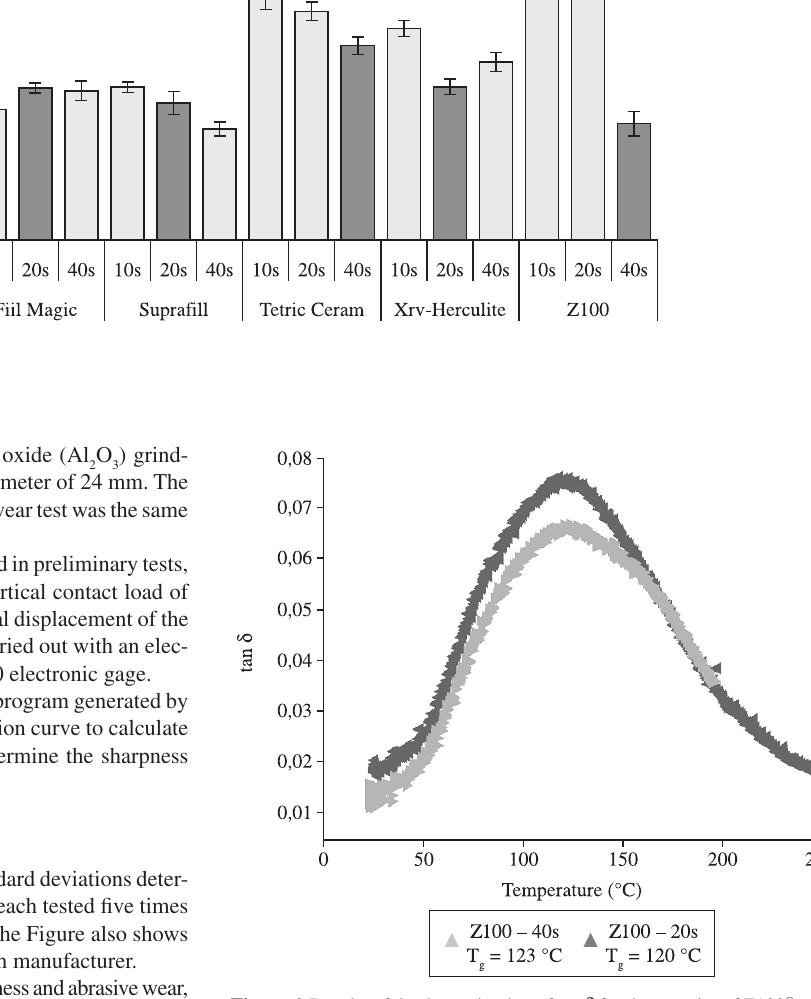
Figure 6. Results of the determination of tan δ for the samples of Z100 ® resin polymerized for 20 and 40